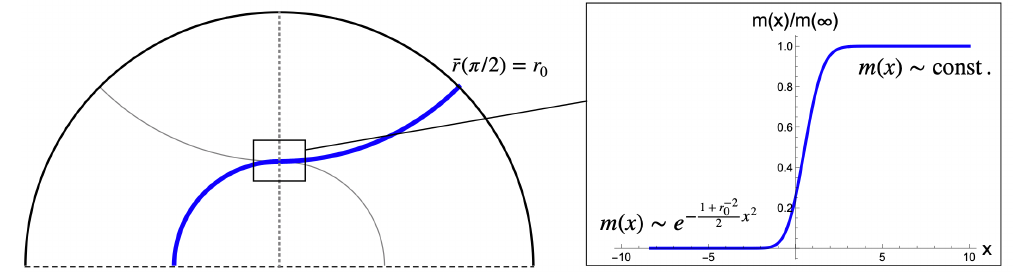
Figure 8 . Relation between the maximum droplet in the soap bubble equation and single droplets in the effective